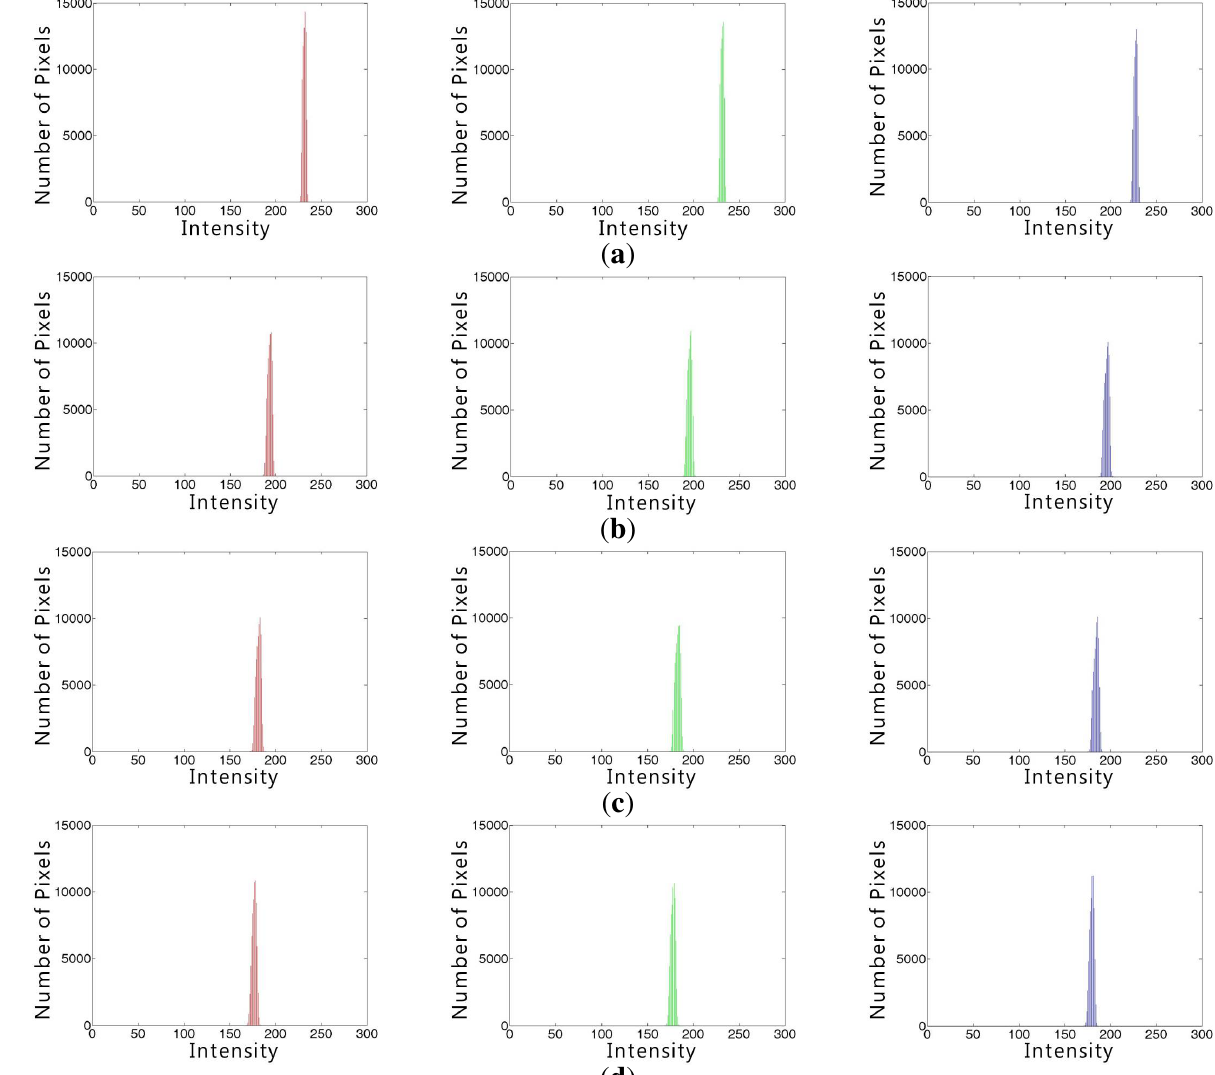
Figure 3. The RGB color histograms of the white regions in Figure 1: ( a ) red, green and blue (from left to right) color histograms of the white regions of the haze-free image shown in Figure 1a; and ( b – d ) red, green and blue color histograms of the hazy images shown in Figure